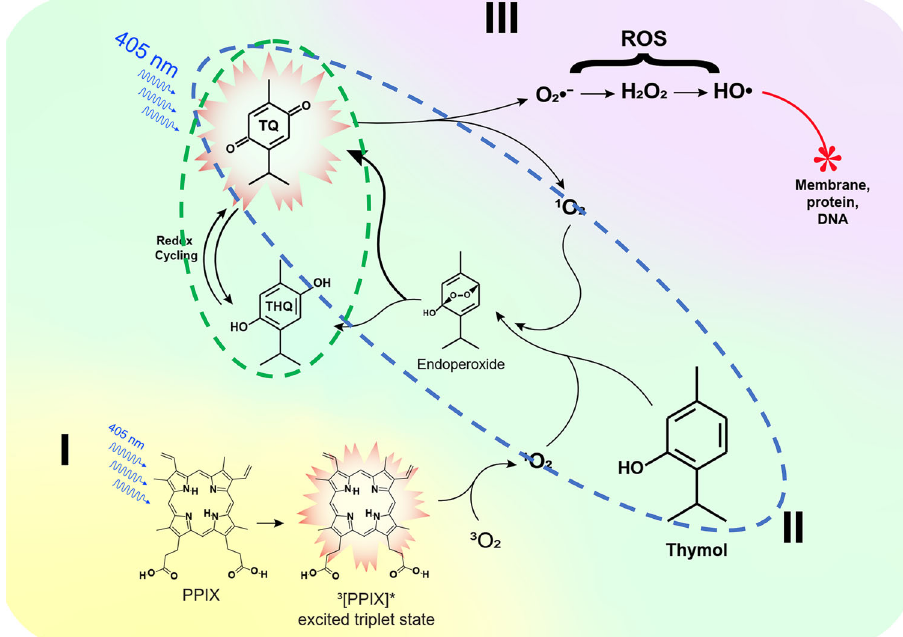
Fig. 7 A schematic of phototoxic cascade reactions in the presence of BL and thymol. Endogenous proporphyrins-like compounds absorb BL to attain an excited triplet-state from an electronic ground state and react with a ground state molecular oxygen ( 3 O 2 ) to generate singlet oxygen ( 1 O 2 ) ( I ). The 1 O 2 oxidizes thymol to form TQ and/or THQ via an endoperoxide intermediate ( II ). The resultant TQ and THQ, particually, TQ act as a photosensitizer and generates more O 2 (cid:129) − and 1 O 2 that can in turn oxidize thymol, continuously replenishing the TQ pool, which forms the fi rst autoxidation cycle (blue-dashed outline). The second autoxidation cycle comprises THQ oxidation into TQ that can be then photo-hydrolyzed into THQ (green dashed outline). O 2 (cid:129) − undergoes dismutation and forms H 2 O 2 that is converted into the most detrimental (cid:129) HO via a Fenton reaction or photolysis ( III ). The deleterious (cid:129) HO initiates a chain reaction that oxidatively damages the